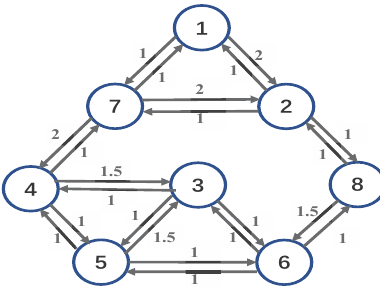
Figure 1. The communication